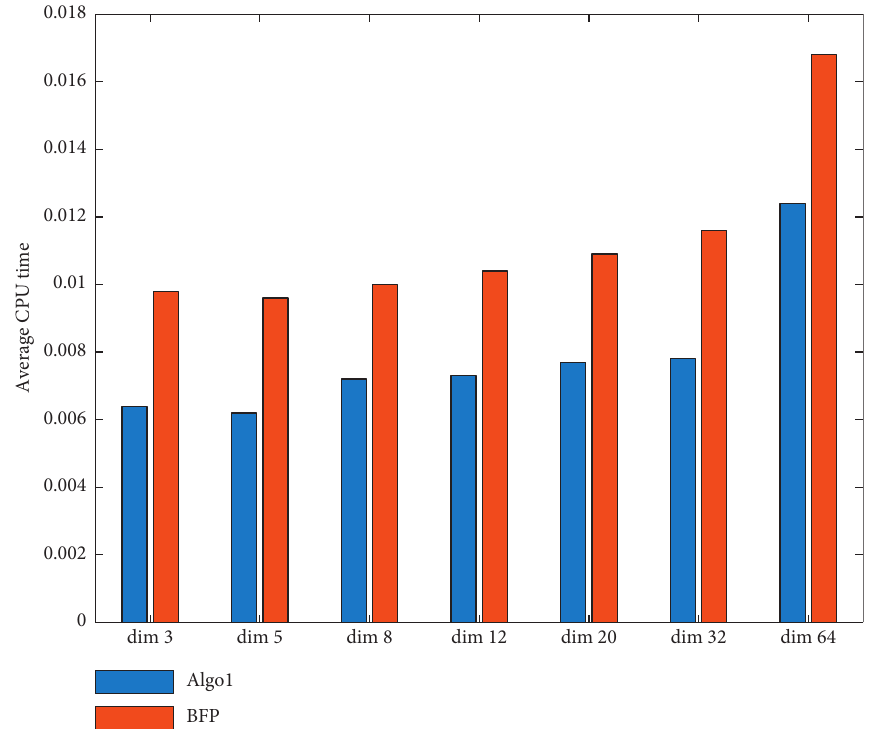
Figure 26: Average CPU time for different